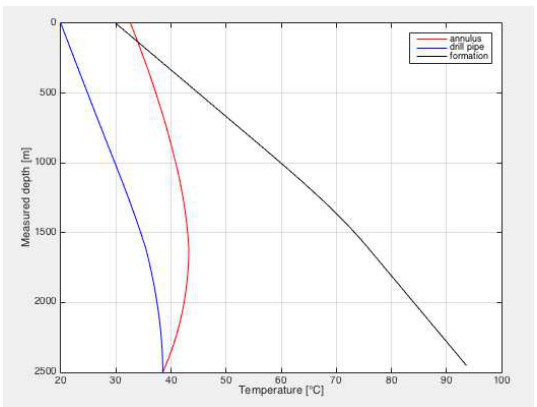
Figure 15: Temperature distribution( ρ = 1000 kg/m 3 )